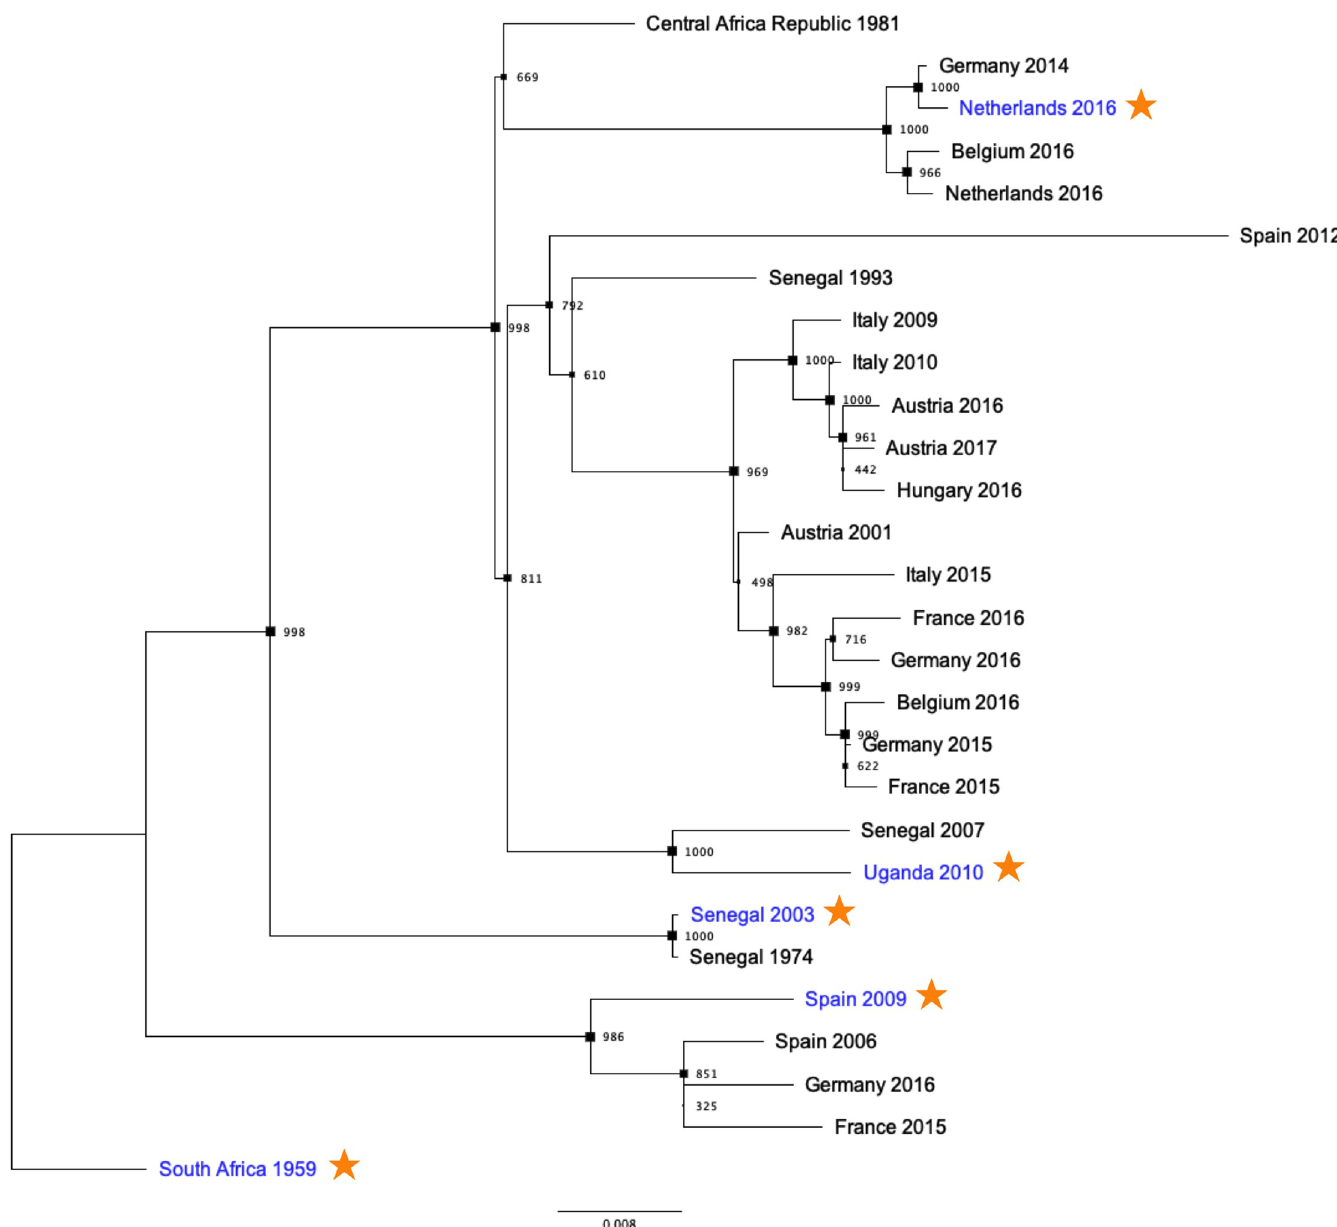
Fig 5. Phylogenetic analysis of African and European USUV strains. A maximum likelihood phylogenetic tree was generated using the USUV strains tested in experimental inoculations (denoted in blue with an orange star) as well as a subset of publicly available USUV sequences. Bootstrap values correspond with node